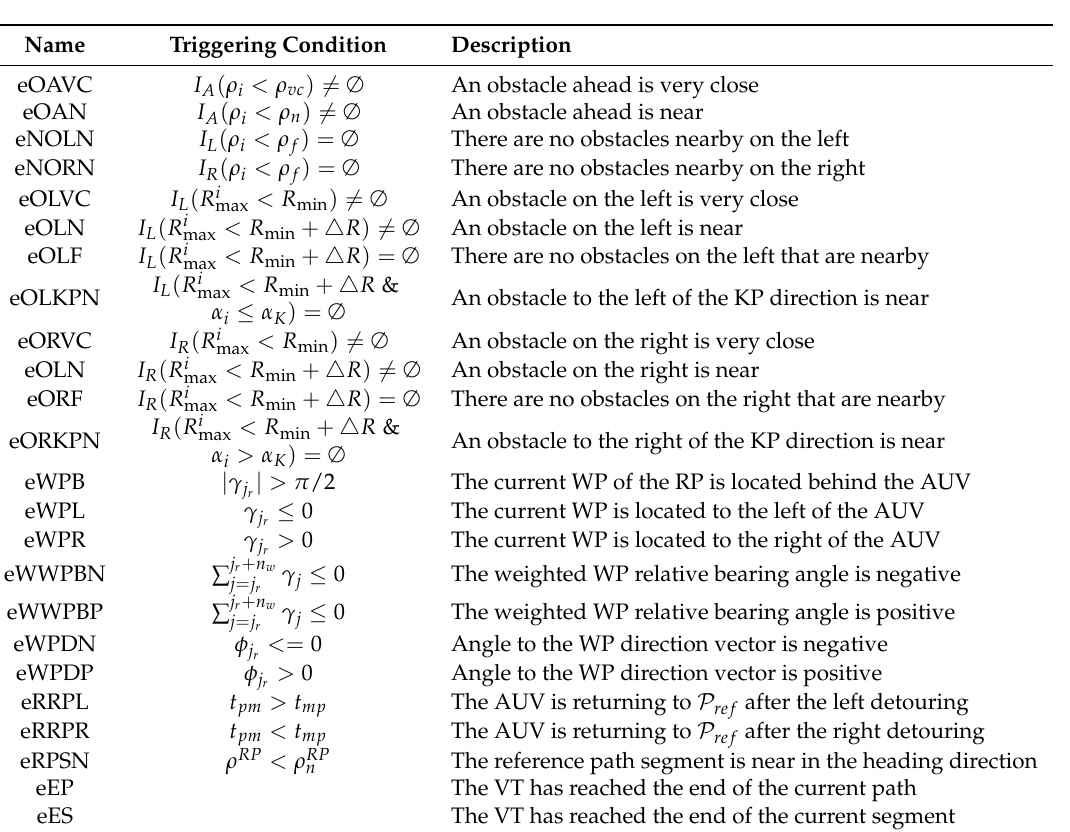
Table 2. Events of the